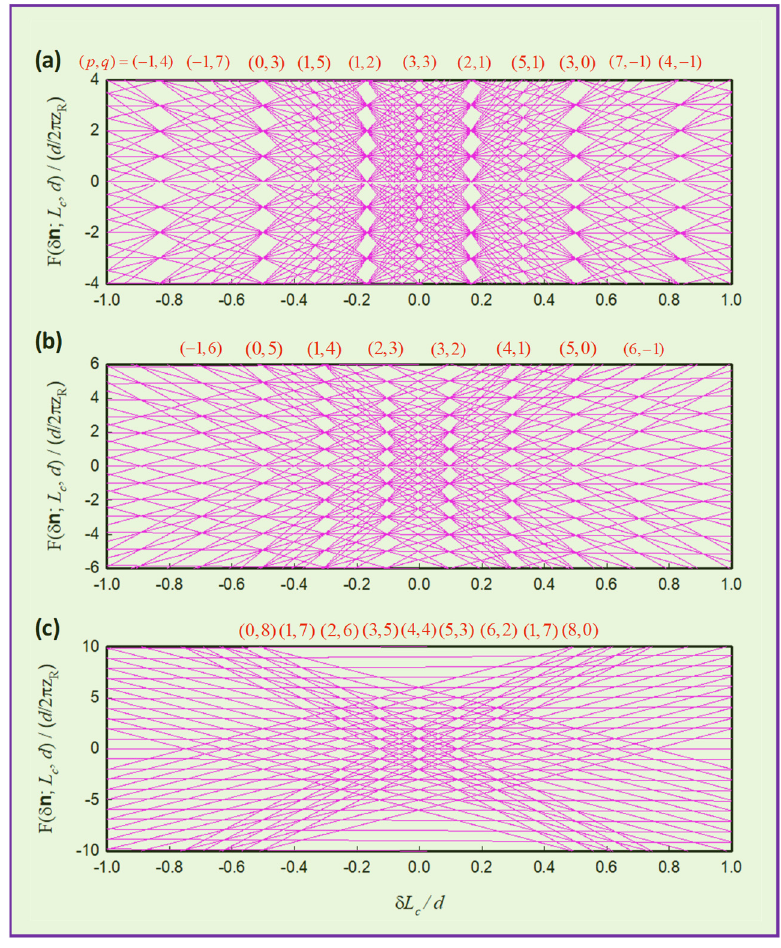
F L d δ n as a function of / L d δ for 10 n δ ≤ with 1,2,3 i = for Figure 10. Relative spectrum ( ; , ) Figure 10. Relative spectrum F ( δ n ; L c , d ) as a function of δ L c / d for | δ n i | ≤ 10 with i = 1,2,3 for c c i three cases of P / Q = ( a ) 1/3; ( b ) 2/5; ( c ) 3/8. three cases of / P Q = ( a ) 1/3; ( b ) 2/5; ( c ) 3/8. (cid:113) (cid:112) λ z R , x / π and w o , y = λ z R , y / π , with z R , x and z R , y , the beam waists are w o , x = where λ is the laser wavelength. In terms of ∆ f T , x , ∆ f T , y , z R , x and z R , y , the parametric